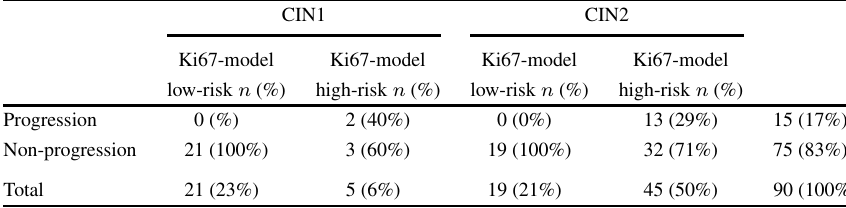
Comparison of disease progression in patients with low and high grade Ki67 quantitative risk